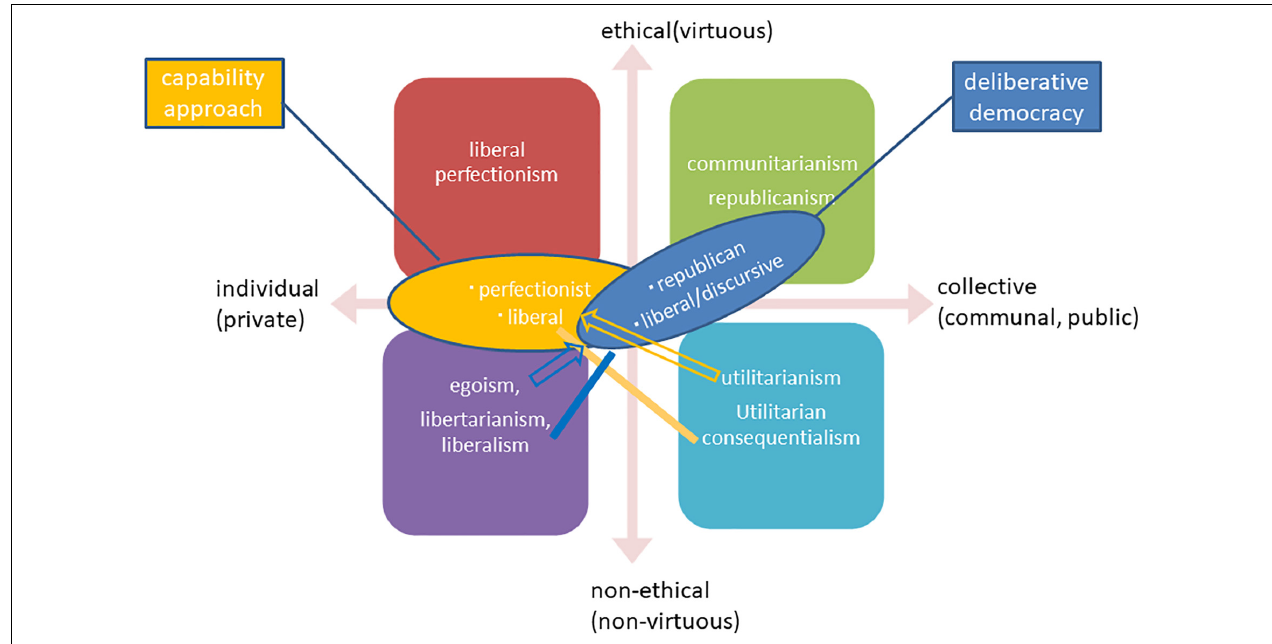
FIGURE 2 | Configuration of political